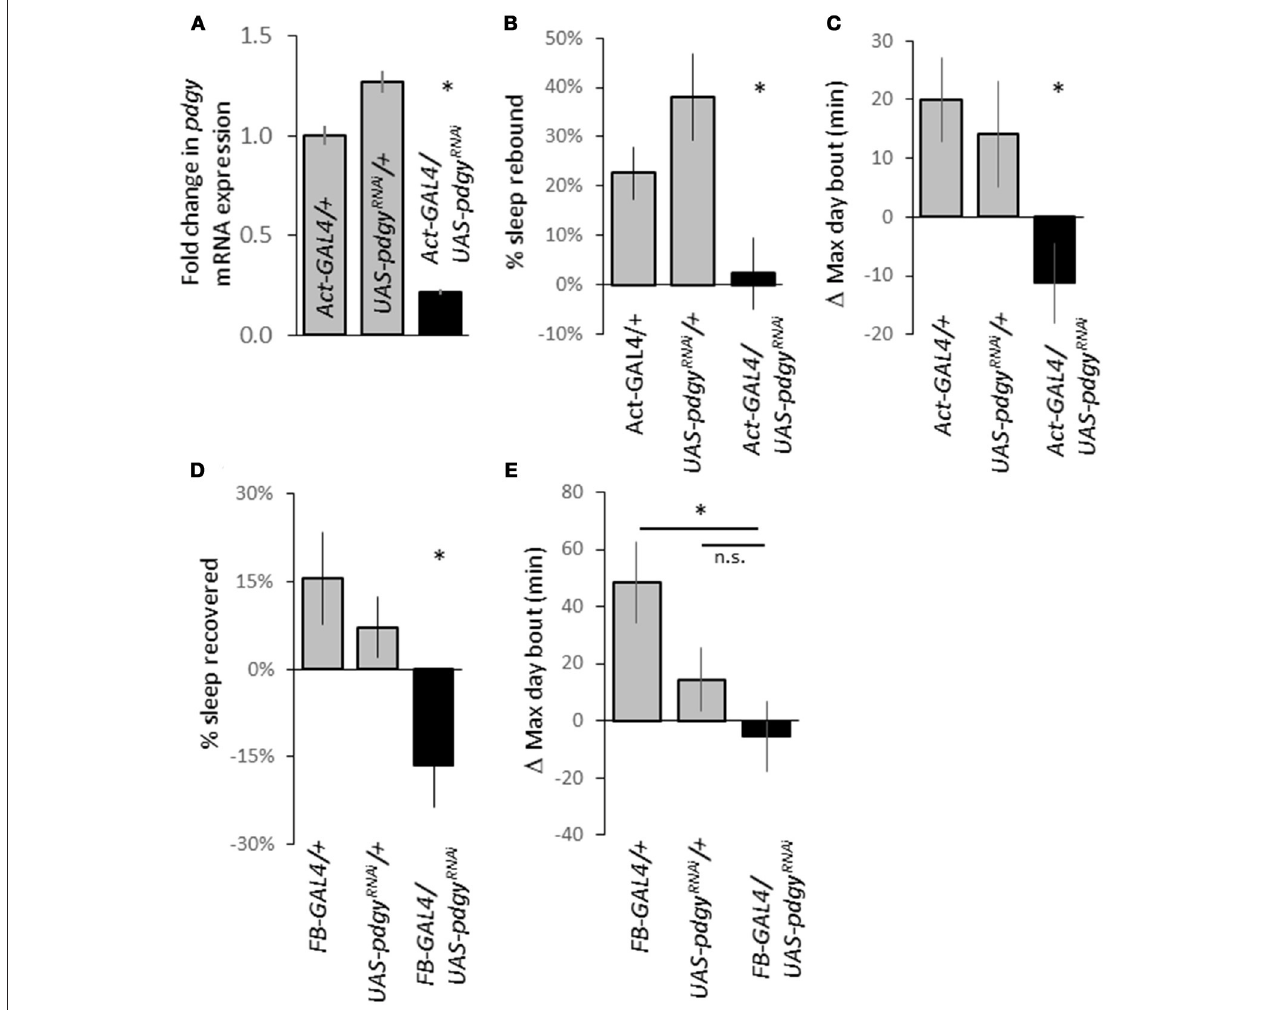
FIGURE 6 | Pdgy knockdown results in a decreased rebound. (A) We confirmed knockdown using real-time qPCR as RNA levels were decreased in Act-GAL4 > UAS-pdgy RNAi compared to background controls. (B) Ubiquitous pdgy RNAi knock down ( Act-GAL4 > UAS-pdgy RNAi ) reduced the response to sleep deprivation compared to the background controls, Act-GAL4/ + and UAS-pdgy RNAi / + . N = Act 50, UAS = 38, Act/UAS = 40). (C) An increase in the maximum day bout was suppressed when pdgy was knocked down ubiquitiously. (D) Knockdown in the fat body ( FB-GAL4 > UAS-pdgy RNAi ) also decreased the response to sleep deprivation compared to background controls FB-GAL4/ + and UAS-pdgy RNAi / + . (E) The change in the maximum day bout in FB-GAL4 > UAS-pdgy RNAi compared to background controls. For (D,E) , N = FB-GAL4/ += 29, UAS-pdgy RNAi / + = 53, FB-GAL4/UAS-pdgy RNAi = 32). * p <